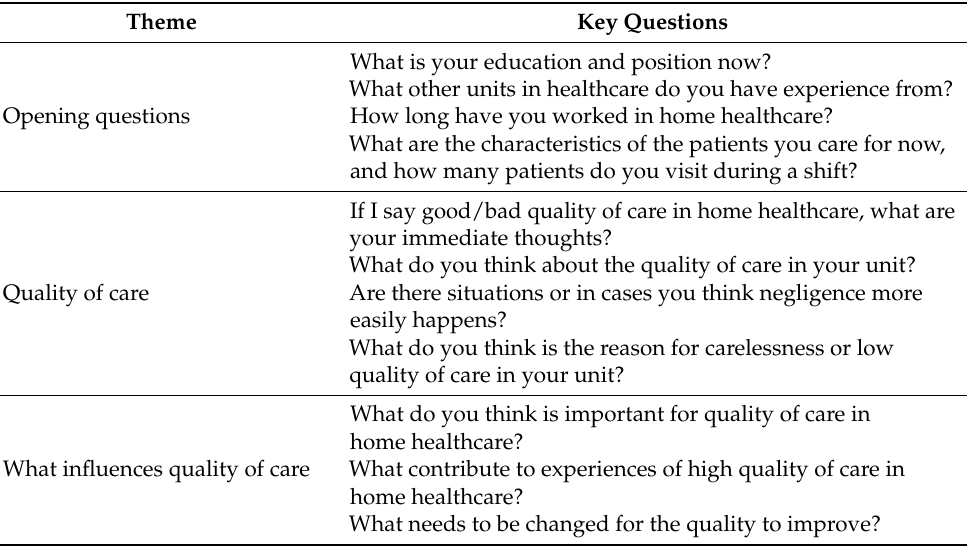
Table 1. Interview guide. Overview of themes and key